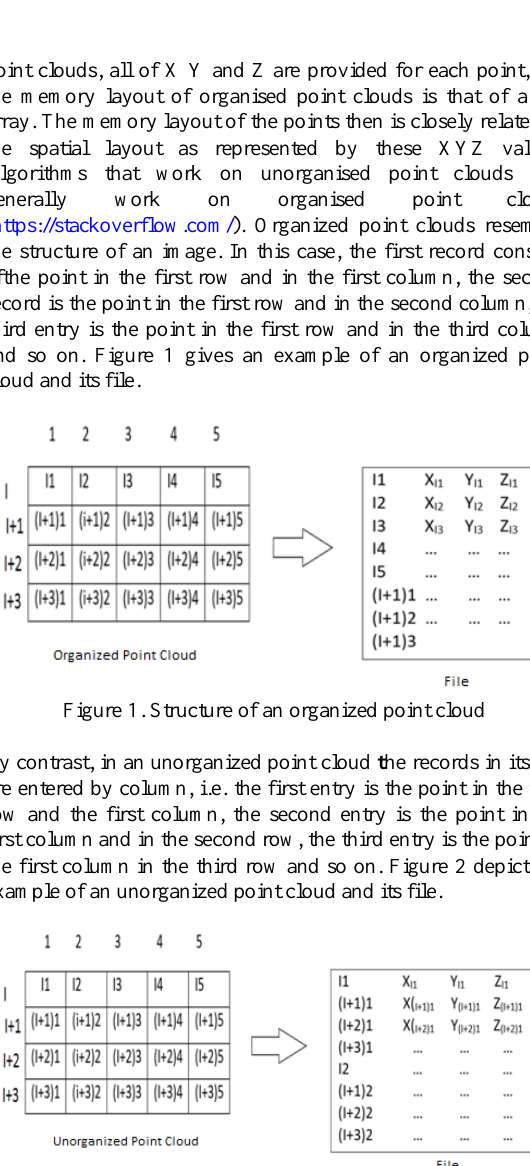
Figure 2. Structure of an unorganized point cloud